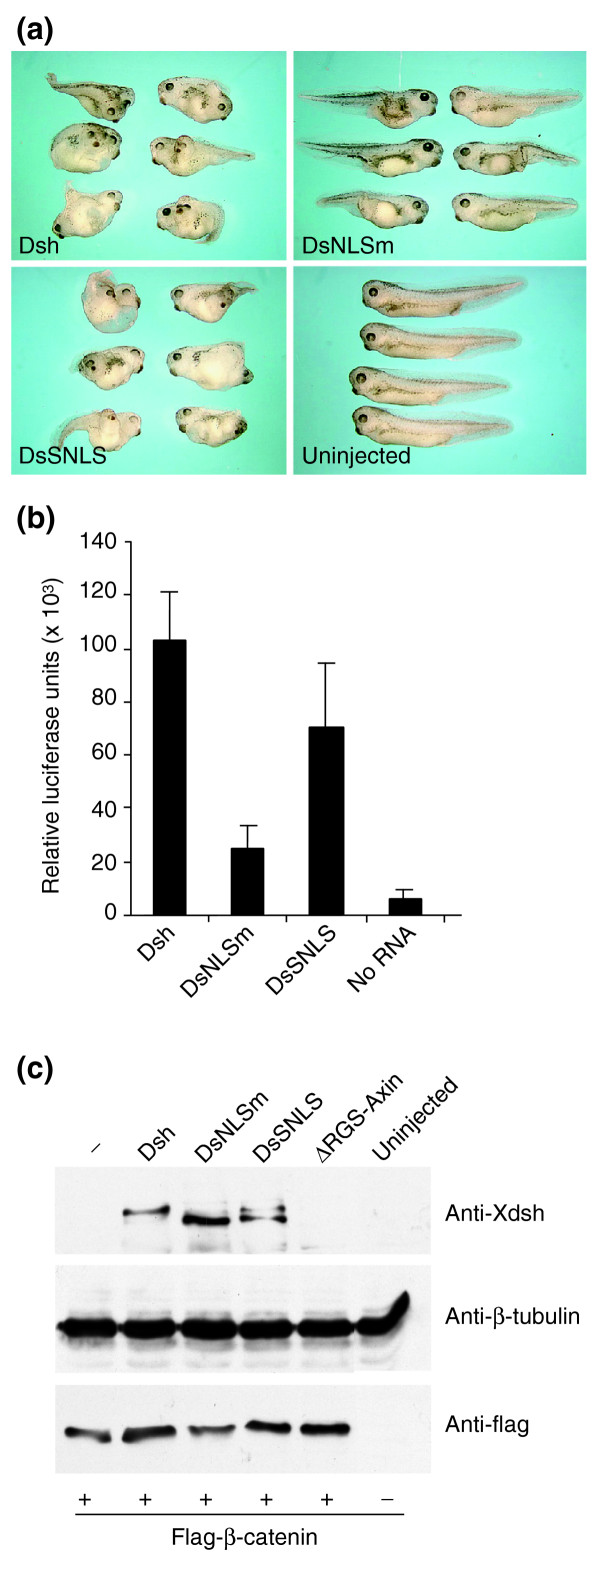
Activation of the Wnt/β-catenin pathway requires nuclear localization of Dsh. (a) Axis-inducing activity of Dsh constructs. One ventral vegetal blastomere of 8-cell embryos was injected with 1 ng Dsh-GFP, DsNLSm, or DsSNLS mRNA as indicated. Uninjected sibling embryos are also shown. (b) Activation of the Siamois reporter gene. The reporter -833pSia-Luc plasmid (20 pg) was coinjected with Dsh-GFP, DsNLSm or DsSNLS mRNA (0.5 ng each) into a single animal ventral blastomere of 8-cell embryos. Injected embryos were lysed at stage 10+ for luciferase activity determination. Results are shown in relative light units as the mean +/- standard deviation from triplicate samples. (c) Requirement for Dsh NLS for the stabilization of β-catenin. Flag-β-catenin mRNA (0.4 ng) was coinjected with Dsh, DsNLSm, DsSNLS or ΔRGS-Axin mRNA (2 ng each) into four animal blastomeres of 4–8-cell embryos. Levels of β-catenin and Dsh constructs were assessed in stage 10 embryo lysates with anti-Flag antibodies and anti-Xdsh antibodies; β-tubulin serves as a loading control. Dsh and DsSNLS, but not DsNLSm, are able to stabilize β-catenin. ΔRGS-Axin was used as a control for an activator of the Wnt pathway.